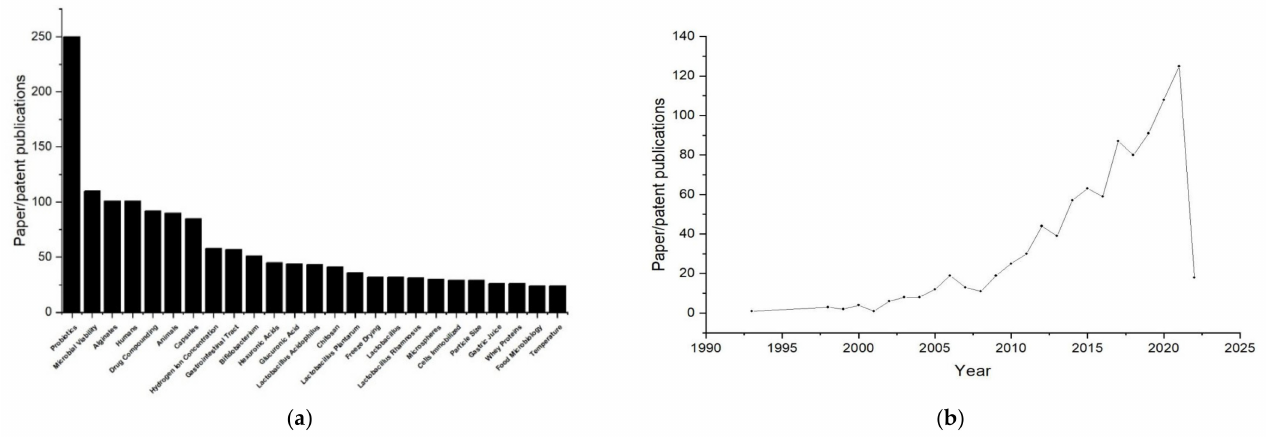
Figure 1. ( a ) Statistical analysis (Based on Mesh Subject Headings) of published papers and patents on probiotics encapsulated within the past years in Web of Science (https://www.webofscience. com/wos/alldb/basic-search, accessed date: 18 March 2022) with the key words of “probiotic and encapsulate”; ( b ) statistical analysis of annual publications of published papers and patents on alginate-related aspects of probiotics within the past years in Web of Science (https://www. webofscience.com/wos/alldb/basic-search, accessed date: 18 March 2022) with the key words of “probiotic and